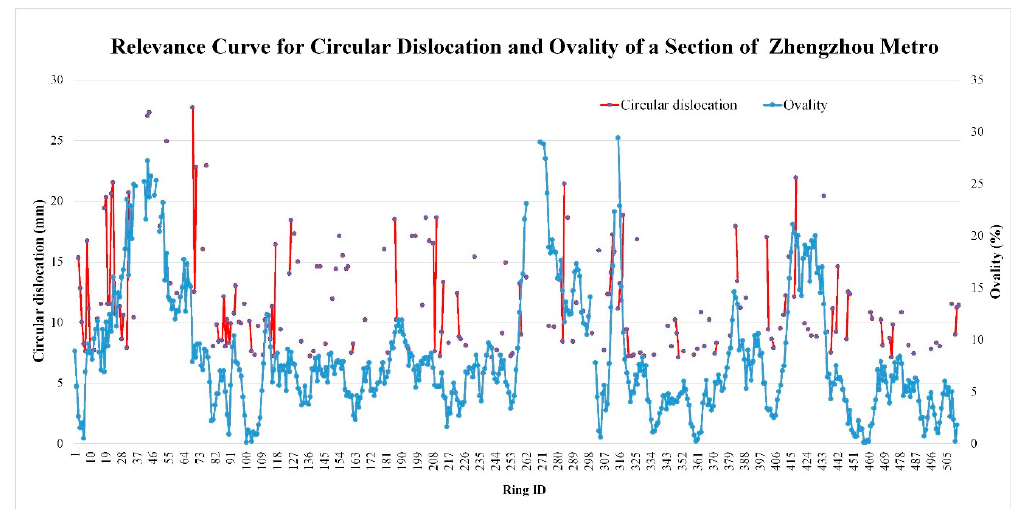
Figure 12. Relevance curve for circular dislocation and ovality.